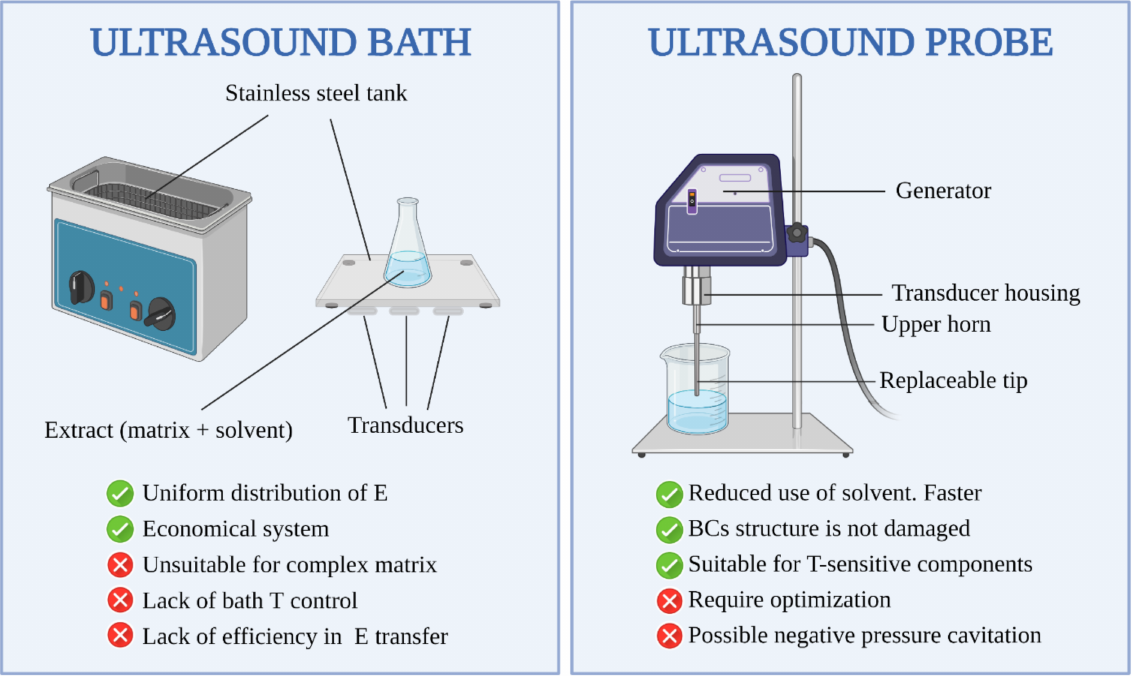
Figure 2. Comparison of major advantages and disadvantages of UAE